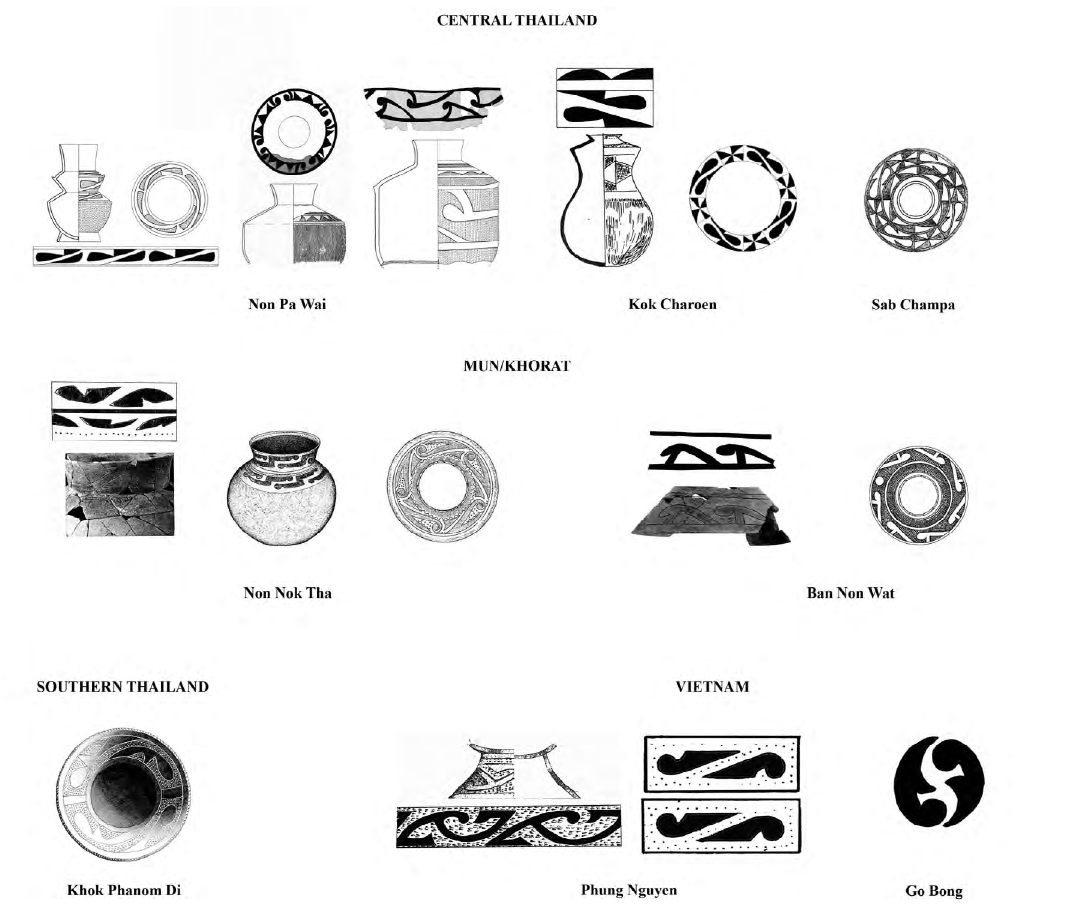
Fig. 4: The stylised human figure motif from early Neolithic sites in Southeast